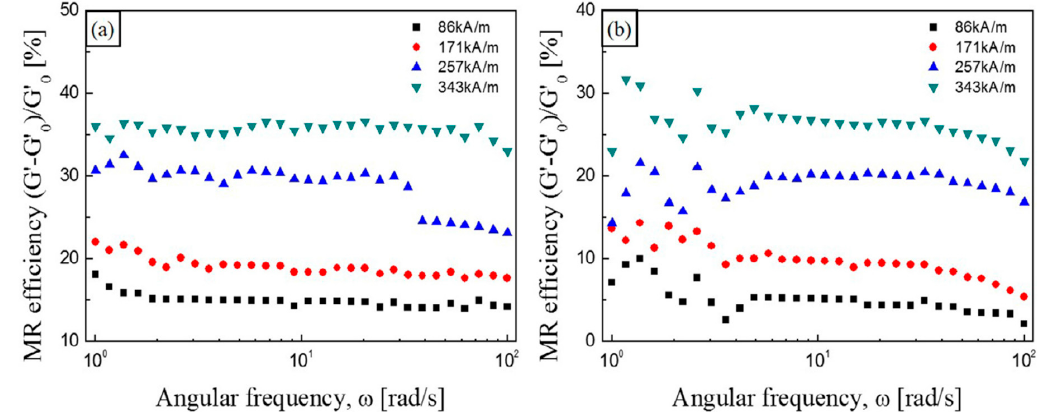
Figure 6. Relative MR effect of ( a ) CI/APTES MR elastomer and ( b ) CI MRE as a function of angular frequency under various magnetic field strengths (reprinted with permission from [79], Copyright 2017 Elsevier B. V., New York, NY, USA).